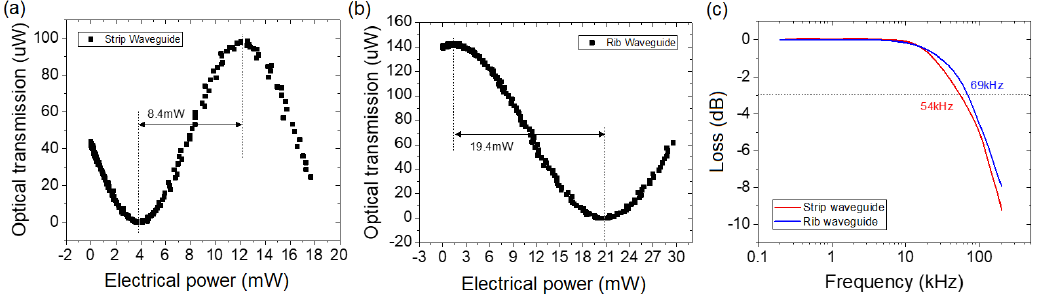
Figure 4. Typical performance of thermal phase shifters for ( a ) strip waveguide configuration, ( b ) rib waveguide configuration and ( c ) switching speed for both waveguide configurations.